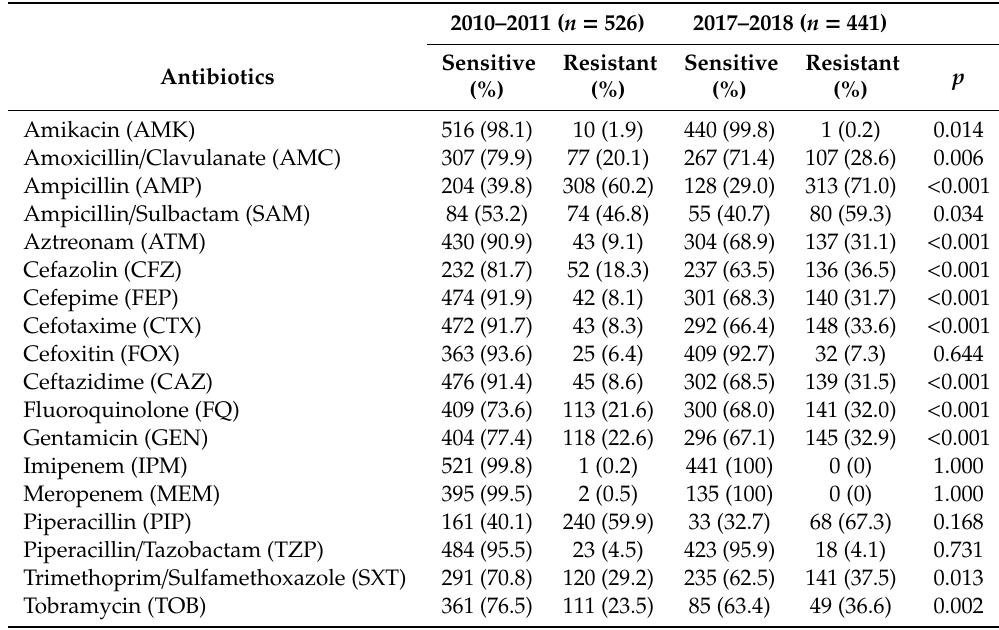
Table 2. Comparison of antibiotic susceptibilities of uropathogenic E. coli